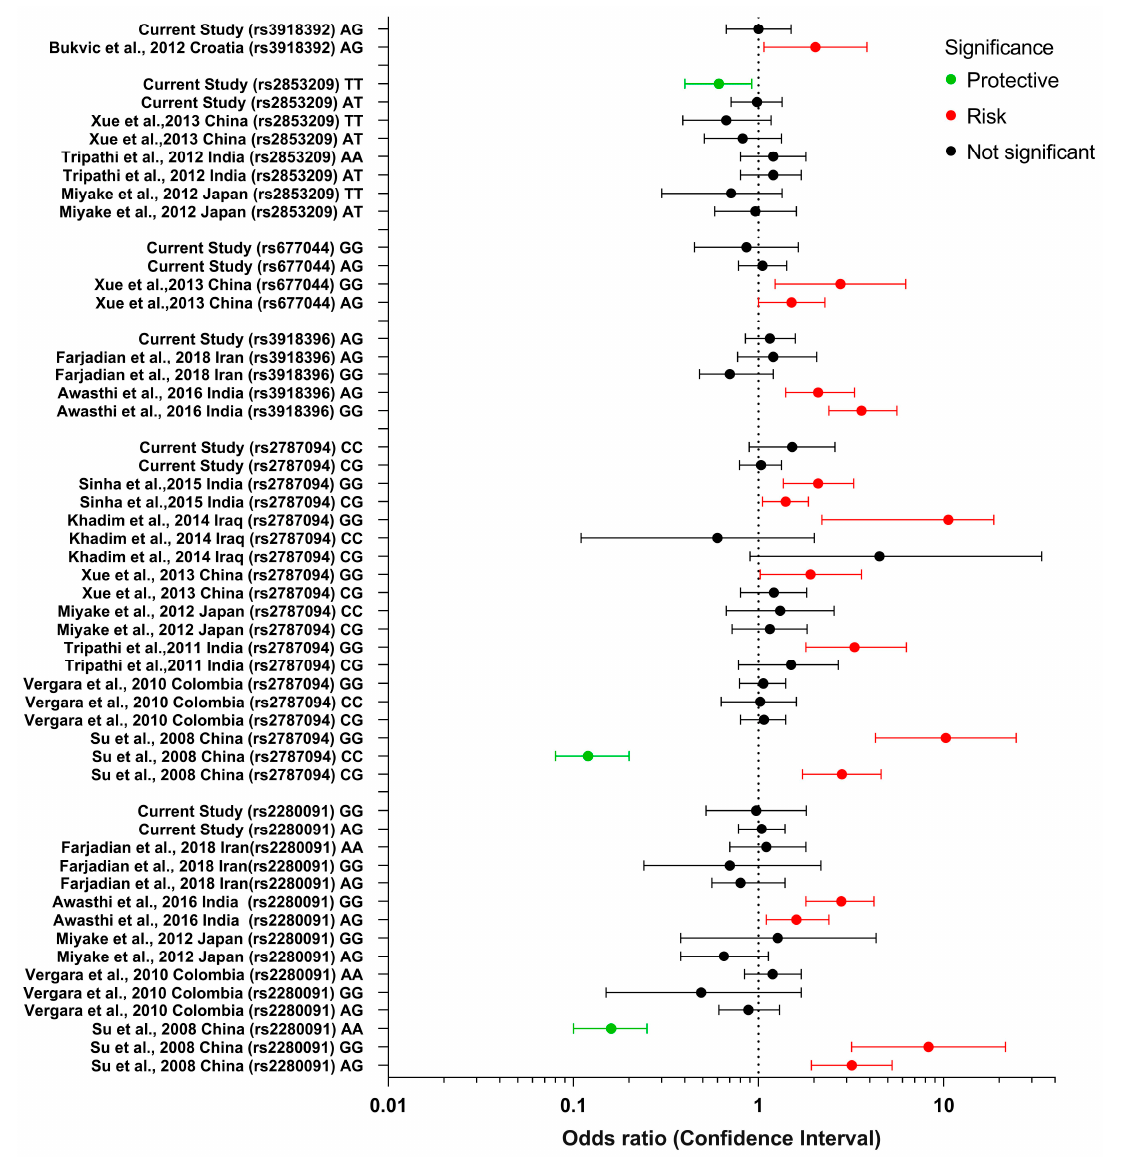
Figure 2. Forest plot of ADAM33 SNPs genotypes rs2280091, rs2787094, rs3918396, rs677044, rs2853209, rs3918392 and their association with asthma according to various studies